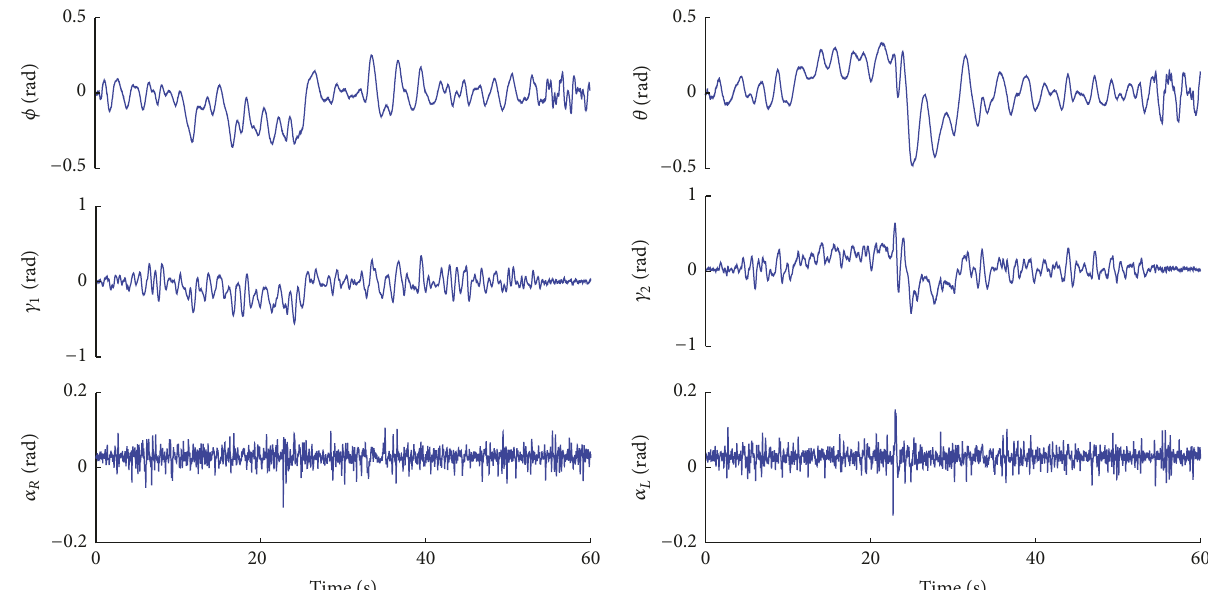
Figure 10: Time evolution of the remaining degrees of freedom. The variations on 𝜙 , 𝜃 , 𝛾 1 , and 𝛾 2 are due to changes on their equilibrium points when external disturbances affect the system.